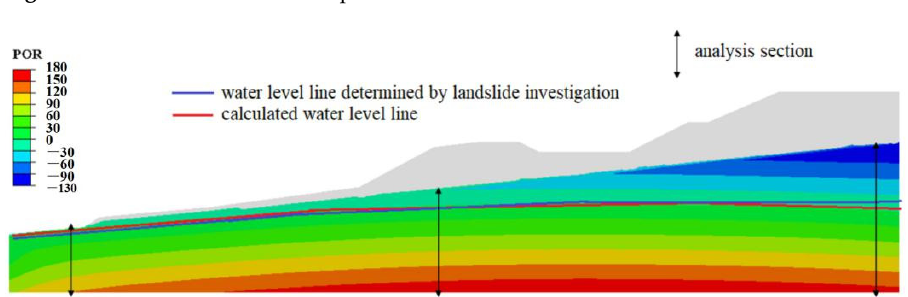
Figure 6. Overall pore pressure of slope.